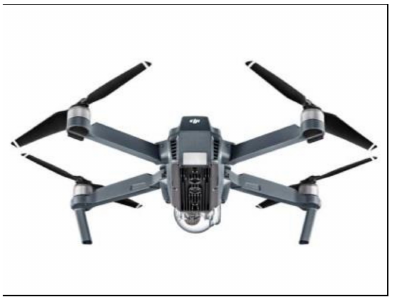
Figure 4. General image of the unmanned aerial vehicle